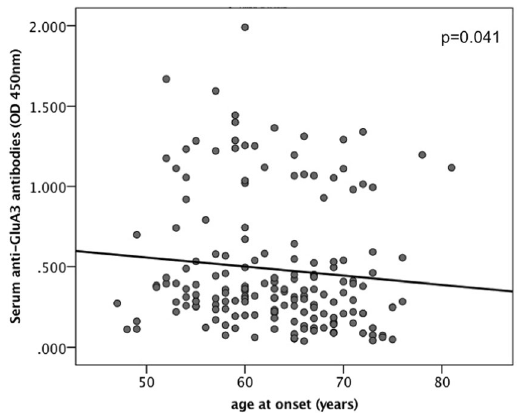
Figure 1. Inverse correlation between age at disease onset and anti-GluA3 antibody titer.